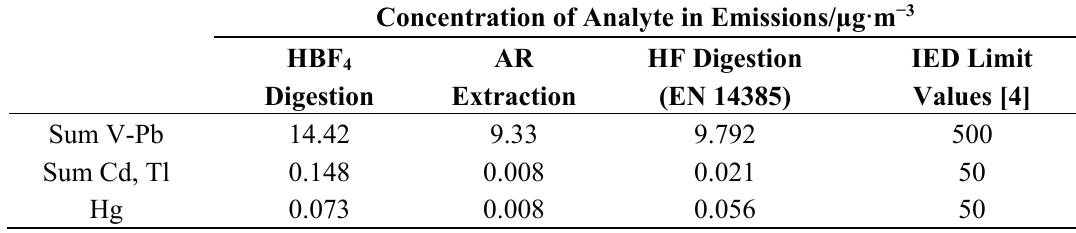
Table 5. Comparison of emission detection limits with IED limit values [4].